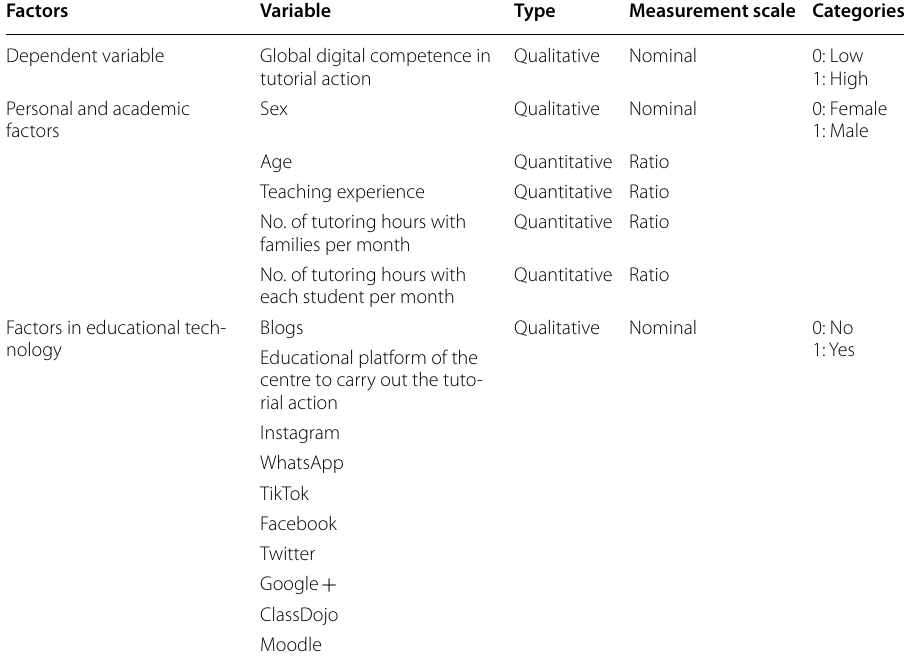
Table 3 Description of variables